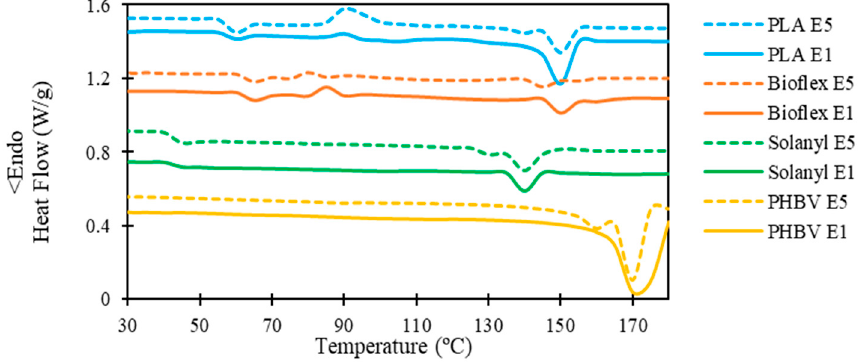
Table 5. Evaluation of the thermal properties of polymers as a function of the recycling process. Polymer